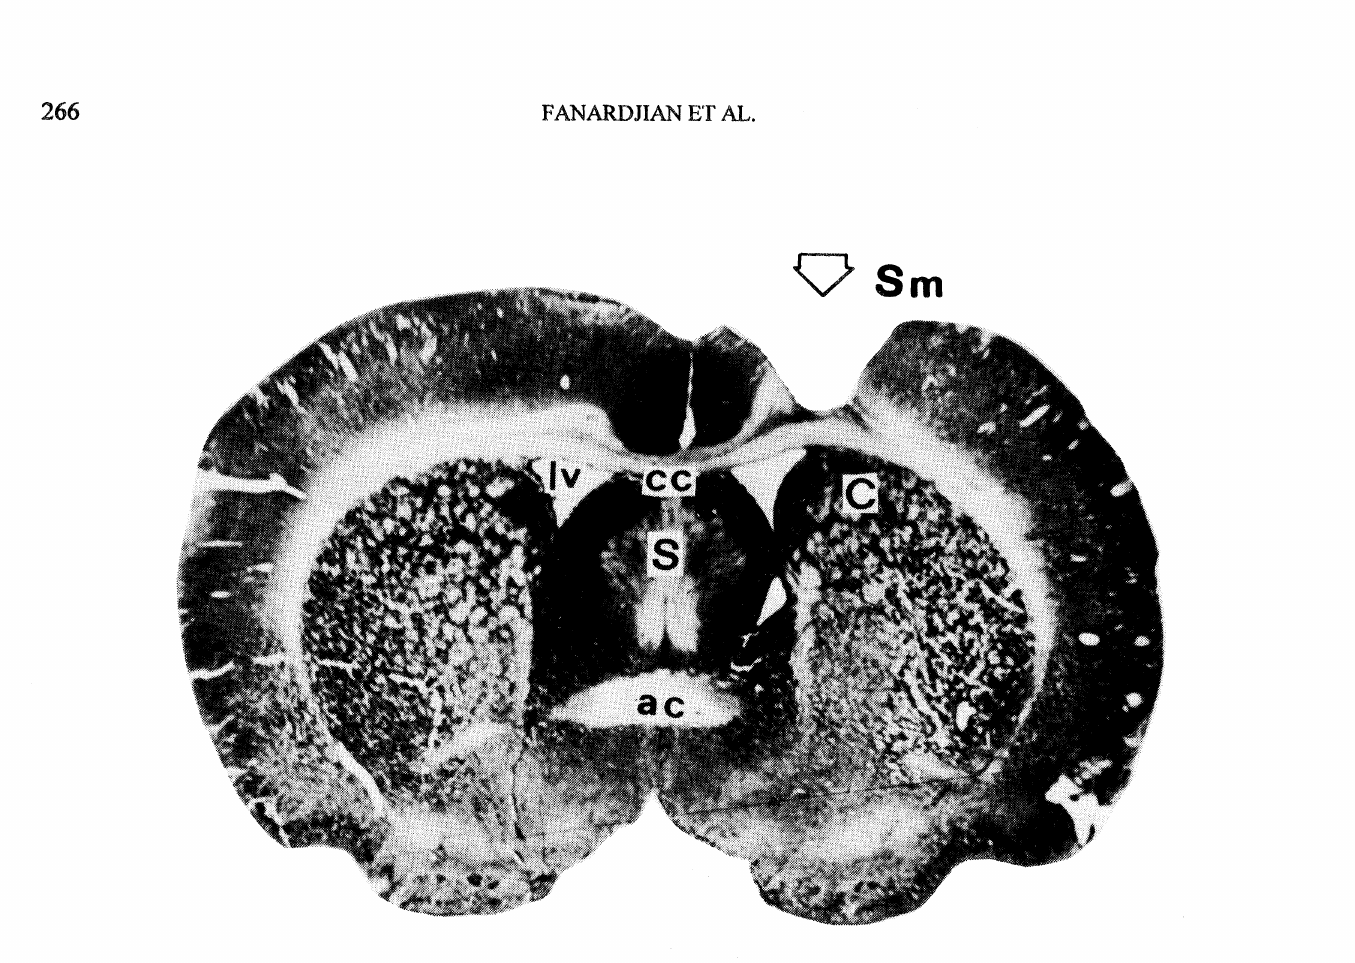
Fig, 2: Microphotograph of the frontal section of the rat cerebral cortex and subcortical structures with the ablation of the cortical sensorimotor area designated by open arrowhead Section was stained using the Nissl method with